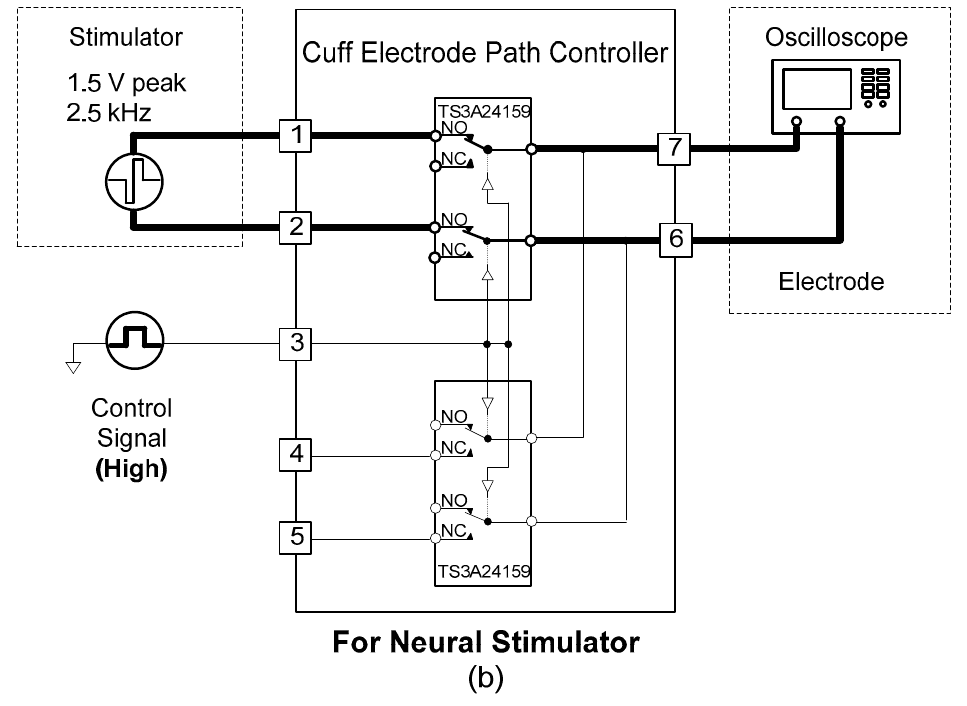
Figure 14. Circuit connections used to evaluate the cuff-electrode path controller: ( a ) for neural amplifier and ( b ) for neural stimulator.